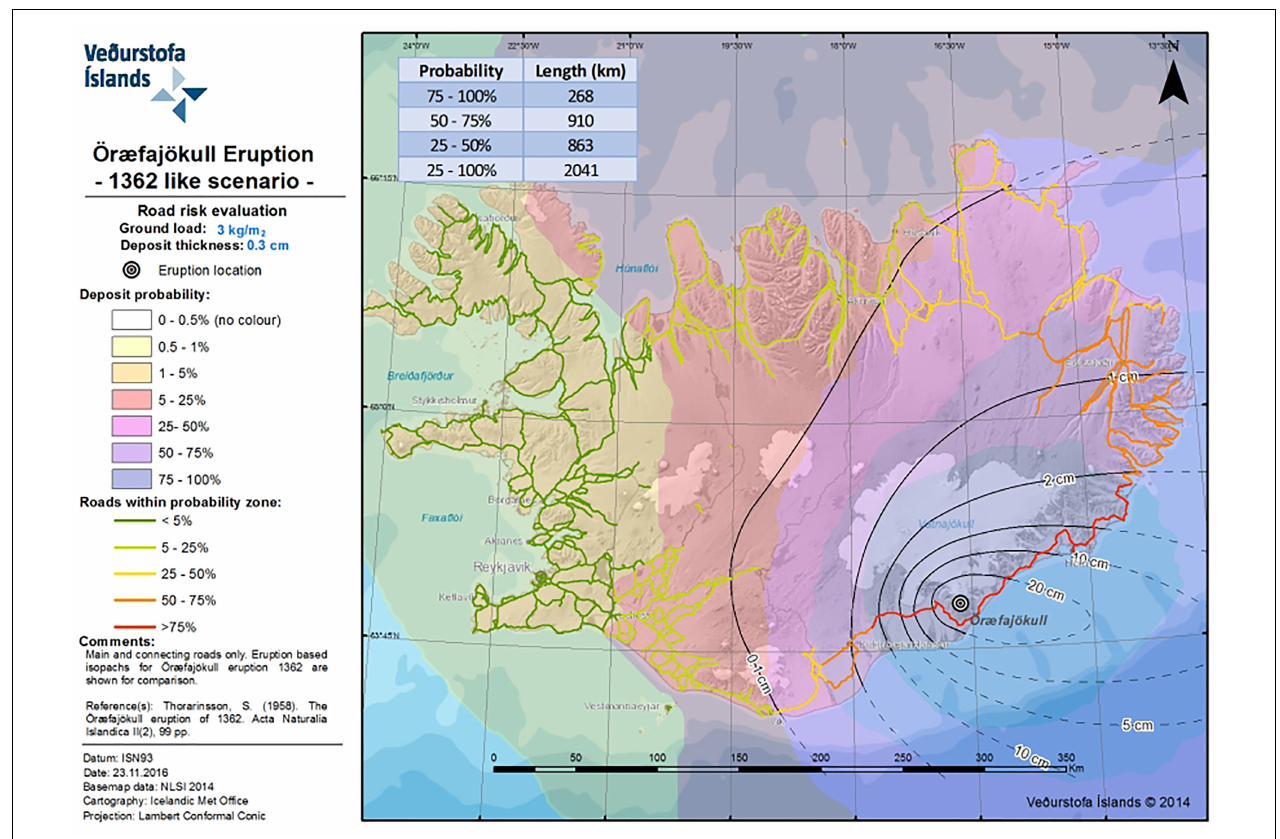
FIGURE 9 | Map showing potential impact of tephra fallout to roads in case of a 1362-like eruption at